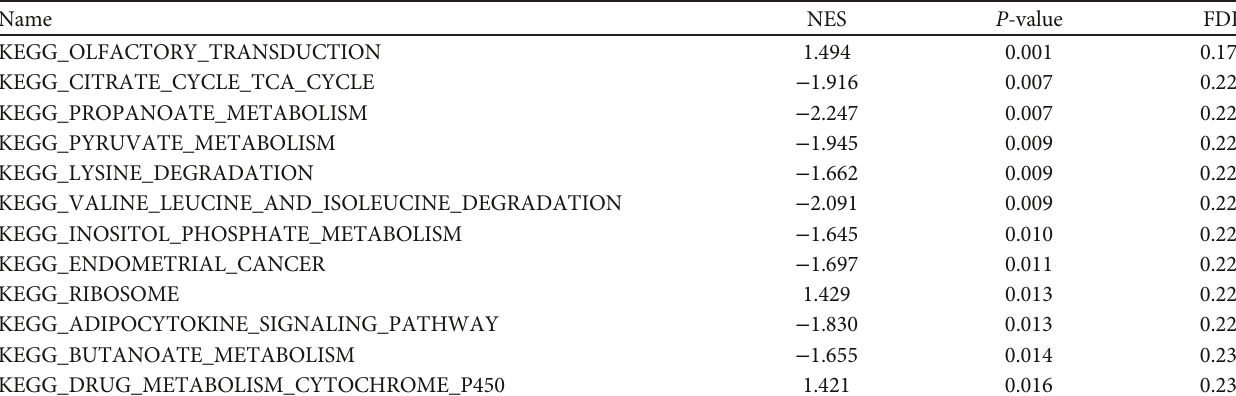
F IGURE 8: Correlation analysis between NUDT1 and immune checkpoints: (a) the correlation analysis of immune checkpoints based on TCGA-KIRC datasets; (b) the correlation analysis of immune checkpoints by using TIMER database. T ABLE 3: Gene sets enriched in the NUDT1